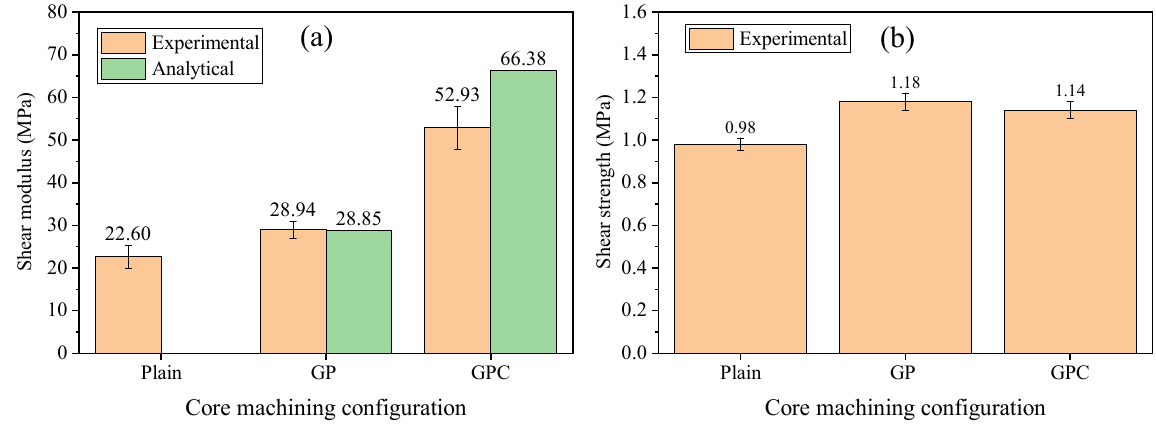
Figure 9. The shear properties of the plain, GP, and GPC cores: ( a ) modulus and ( b ) strength.